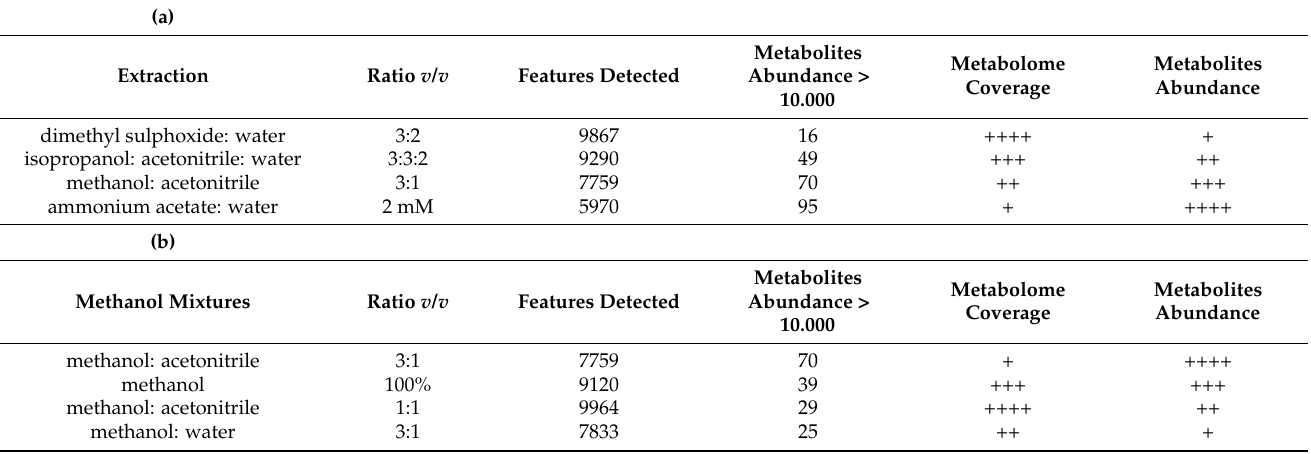
Figure 3. Overview of sample selection, storage and DBS preparation. ( a ) Type of samples received from physician per patient. The samples received from each patient were in the form of either DBS card, or whole EDTA blood, or DBS and EDTA. Stability study 2 comprised only patients with DBS and EDTA samples combined. ( b ) Three different categories of samples were used in stability study 2. Table 1. Summary of the amount and type of solvent used and its performance on DBS